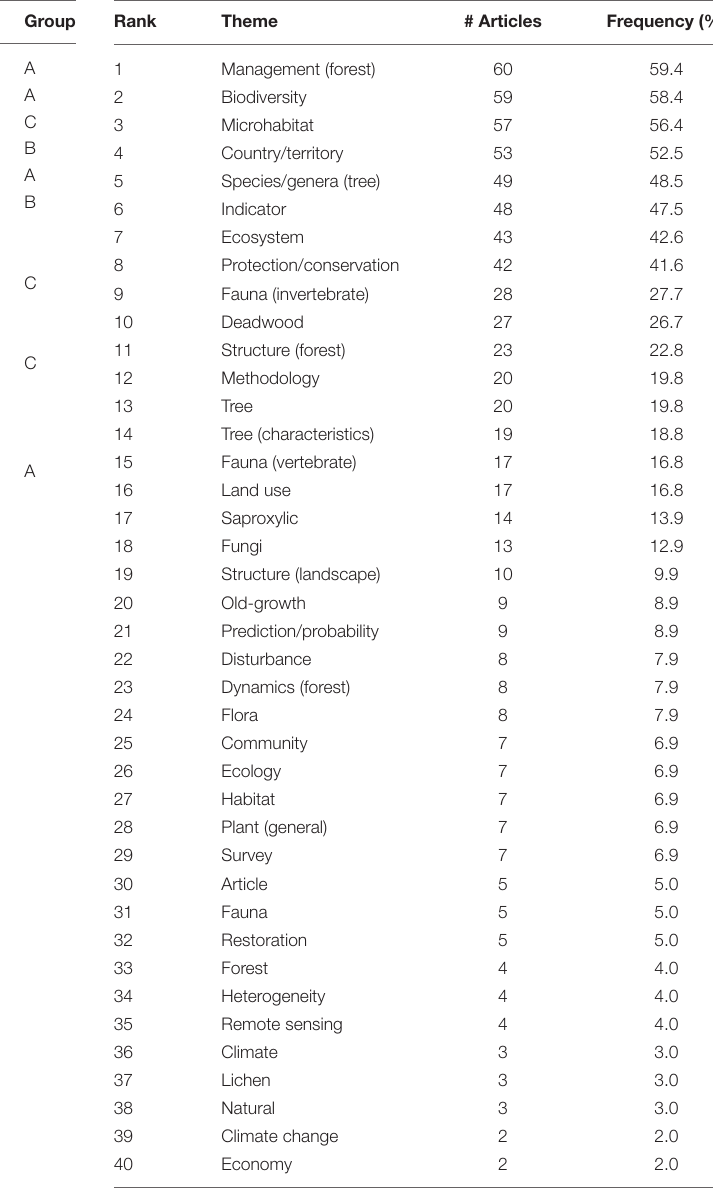
TABLE 2 | Number and frequency of articles presenting themes identified from the Keywords